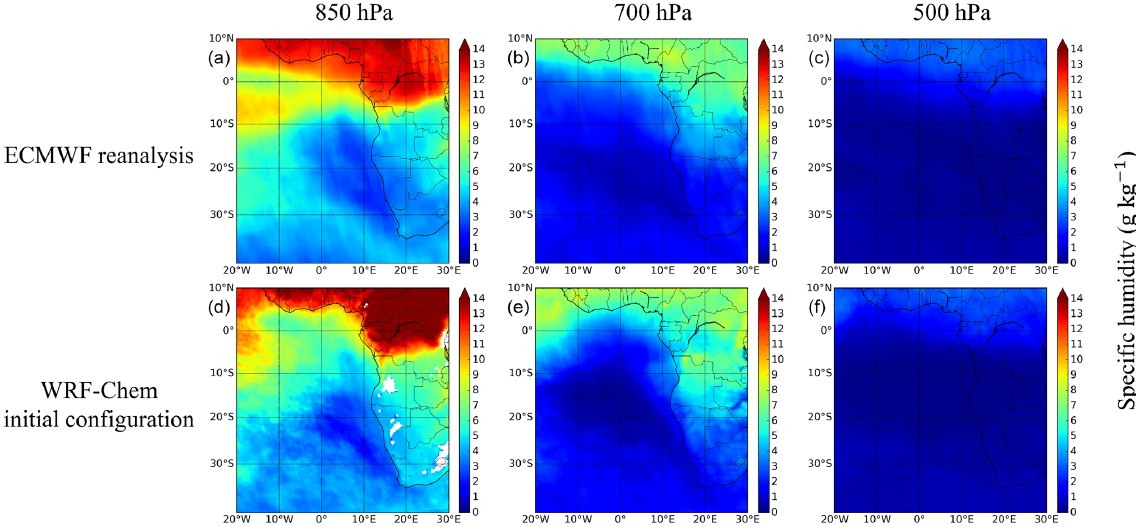
Figure 5. Same as Fig. 4 but for specific humidity (in gkg − 1